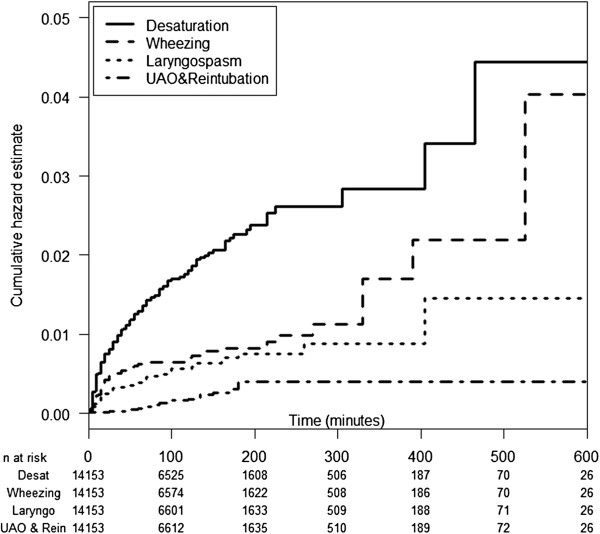
Nelson-Aalen plot of the first event of different forms of intraoperative respiratory event. Desat; Desaturation, Laryngo; Laryngospasm, UAO & rein; Upper airway obstruction in combination with reintubation.